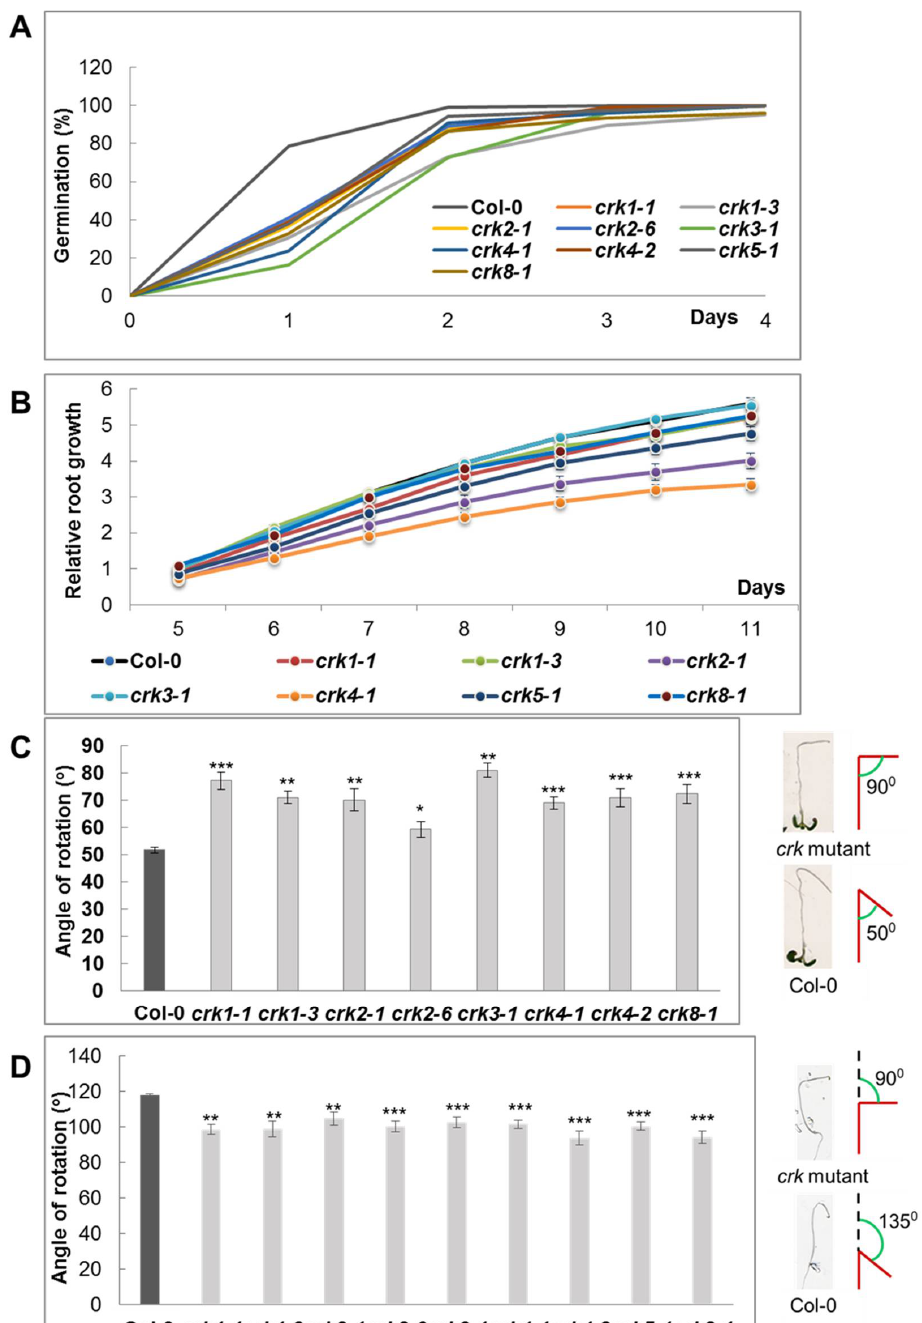
Figure 4. Germination and early seedling development of A tcrk mutants. ( A ) Germination of At crk mutants on standard half strength Murashige and Skoog (MS) medium [15]; ( B ) Root growth rate of seedlings grown on vertical plates for 14 days under continuous light conditions; ( C ) Root gravitropic test. Six days old, vertically grown seedlings were gravistimulated by changing orientation of plates by 135° and the angle of root bending was recorded 24 h after reorientation; ( D ) Hypocotyl gravitropic test. Seedlings were germinated in dark and plates were reoriented 5 days after germination. Hypocotyl angles were scored 24 h after; ( C , D ) Pictograms show the mode of root and hypocotyl bending measurements. Values are means ± SE. Statistically significant values were calculated by Student’s t test for * p < 0.05, ** p < 0.005 and *** p < 0.0005 ( n = 30, two independent biological repetitions).